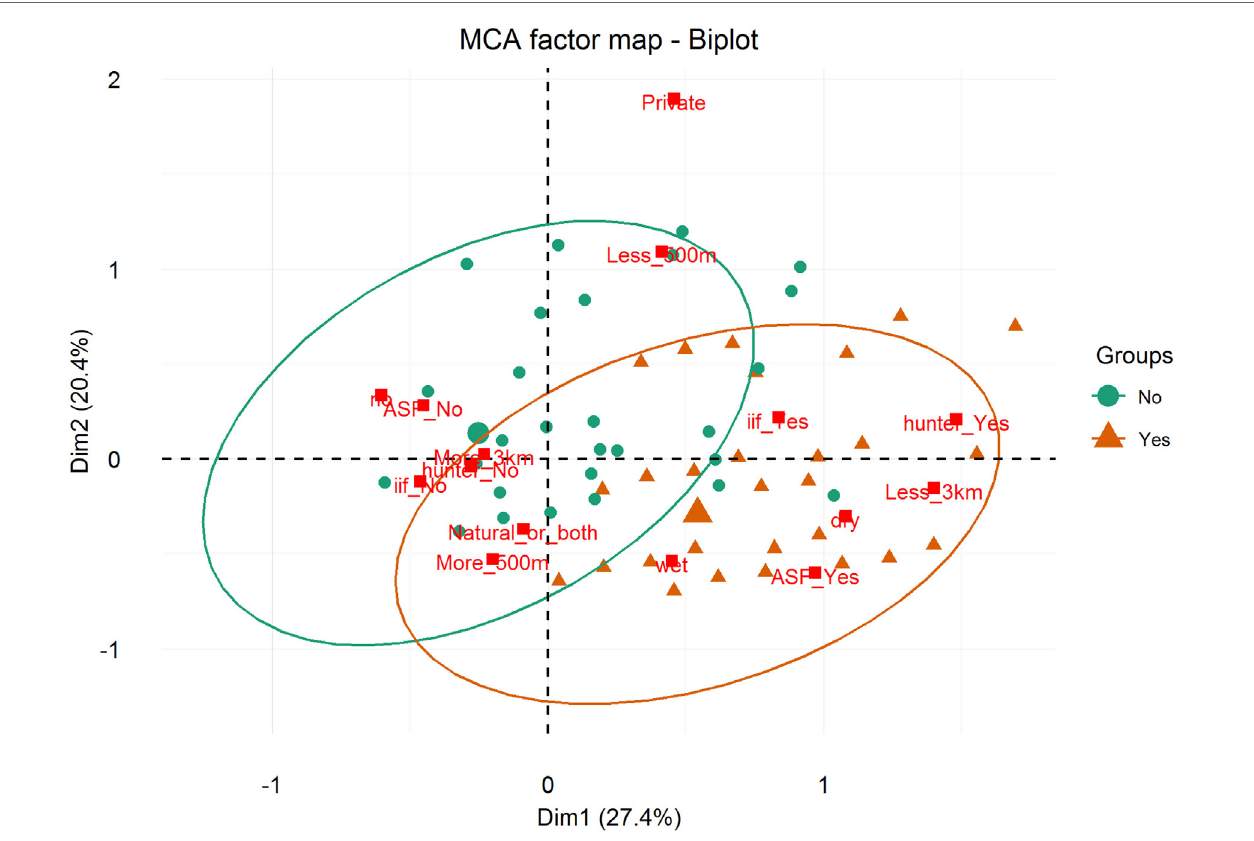
FigUre 6 | associations between asF occurrence and several categorical variables depicted by a multiple correspondence analysis, from data collected during individual interviews carried out in pig owning household in nwoya District, Uganda . Coordinates of the categorical variables [namely, being a hunter, having indirect interactions with either warthog (WH) or bushpig, having a WH burrow less than 3 km from the HH, and season of ASF occurrence] are indicated by squares. Individuals with ASF occurrence is indicated by orange triangles, whereas those with ASF absence are indicated by green dots. Ellipses represent point concentrations. ASF.outbreak (ASF_Yes/ASF_No); Distance.to.Burrow = HH distance from a WH burrow (less than 3 km/more than 3 km); Being. Hunter = respondent being a hunter (hunter_Yes/hunter_No); Indirect.interaction (ii_Yes/ii_No); Season = season of the ASF outbreak (dry/wet/no; “no” refers to no ASF outbreaks reported by the respondent); Water.Distance = HH distance from the pig’s water source (more_500 m/less_500 m); and Water.Source (private/